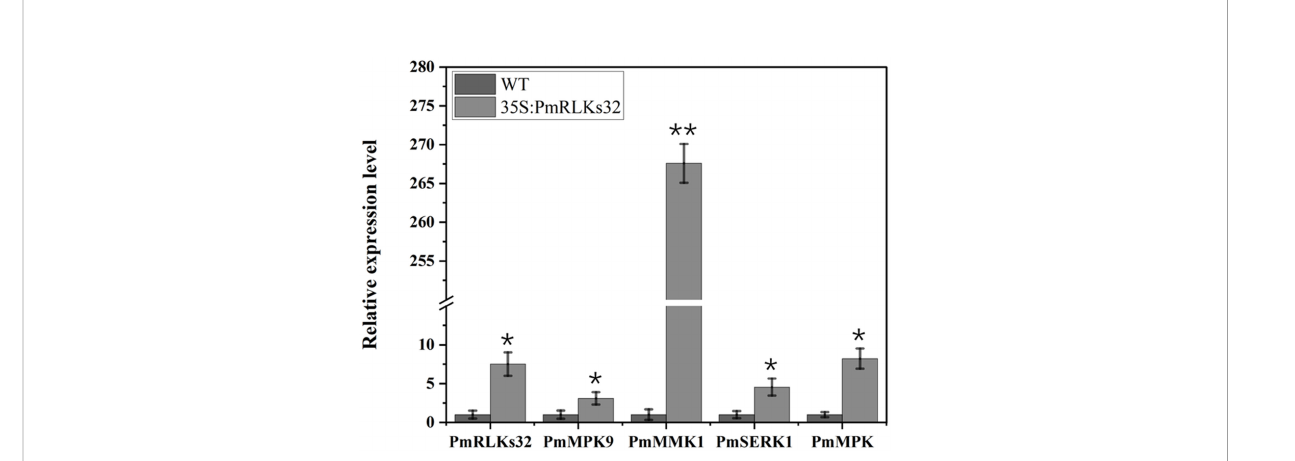
FIGURE 5 Gene expression downstream of PmRLKs32 . The scale represents relative expression levels based on the log 2 (2 − DD C t ) values. The asterisks indicate signi fi cant differences between each time point of the wild-type (WT) and 35S: PmRLKs32 -overexpression plants. * p < 0.05, ** p <